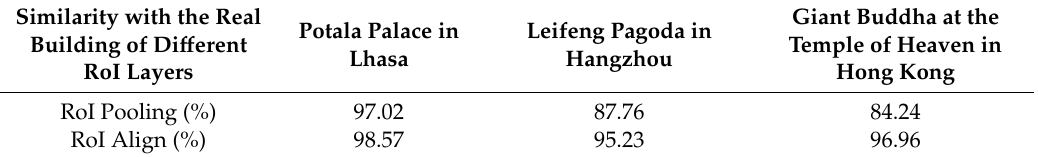
Table 4. Building detection results depend on different RoI layers.